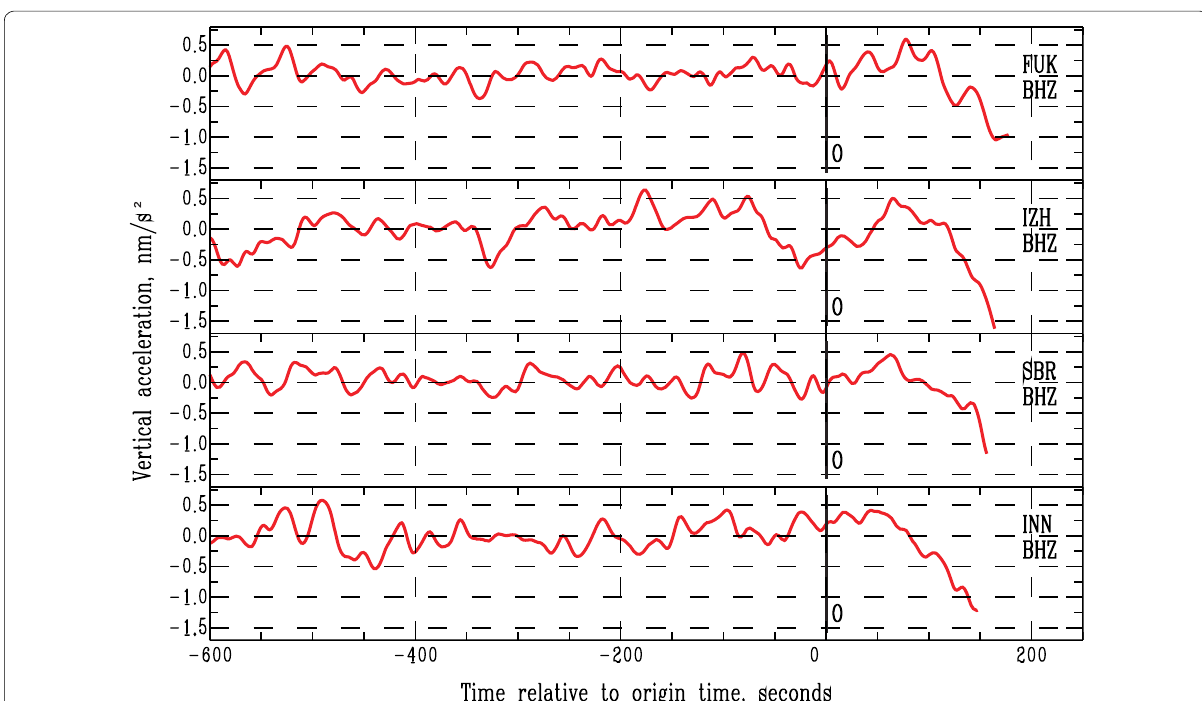
Fig. 3 Objective comparison between PEGS signals observed in Southwest Japan. All signals have been processed using the V17 procedure and the FUK signal (top row) is therefore exactly the same as the one shown in Figs. 1 and 3 of V17. The other three signals are the only other ones among the stations shown in Fig. 2 of K19 that meet the quality criterion of V17. All signals show consistent PEGS, supporting the use of only one of them (FUK) in the V17 study. Due to its correct data processing and appropriate noise considerations, this figure is the logical alternative to Fig. 2b of